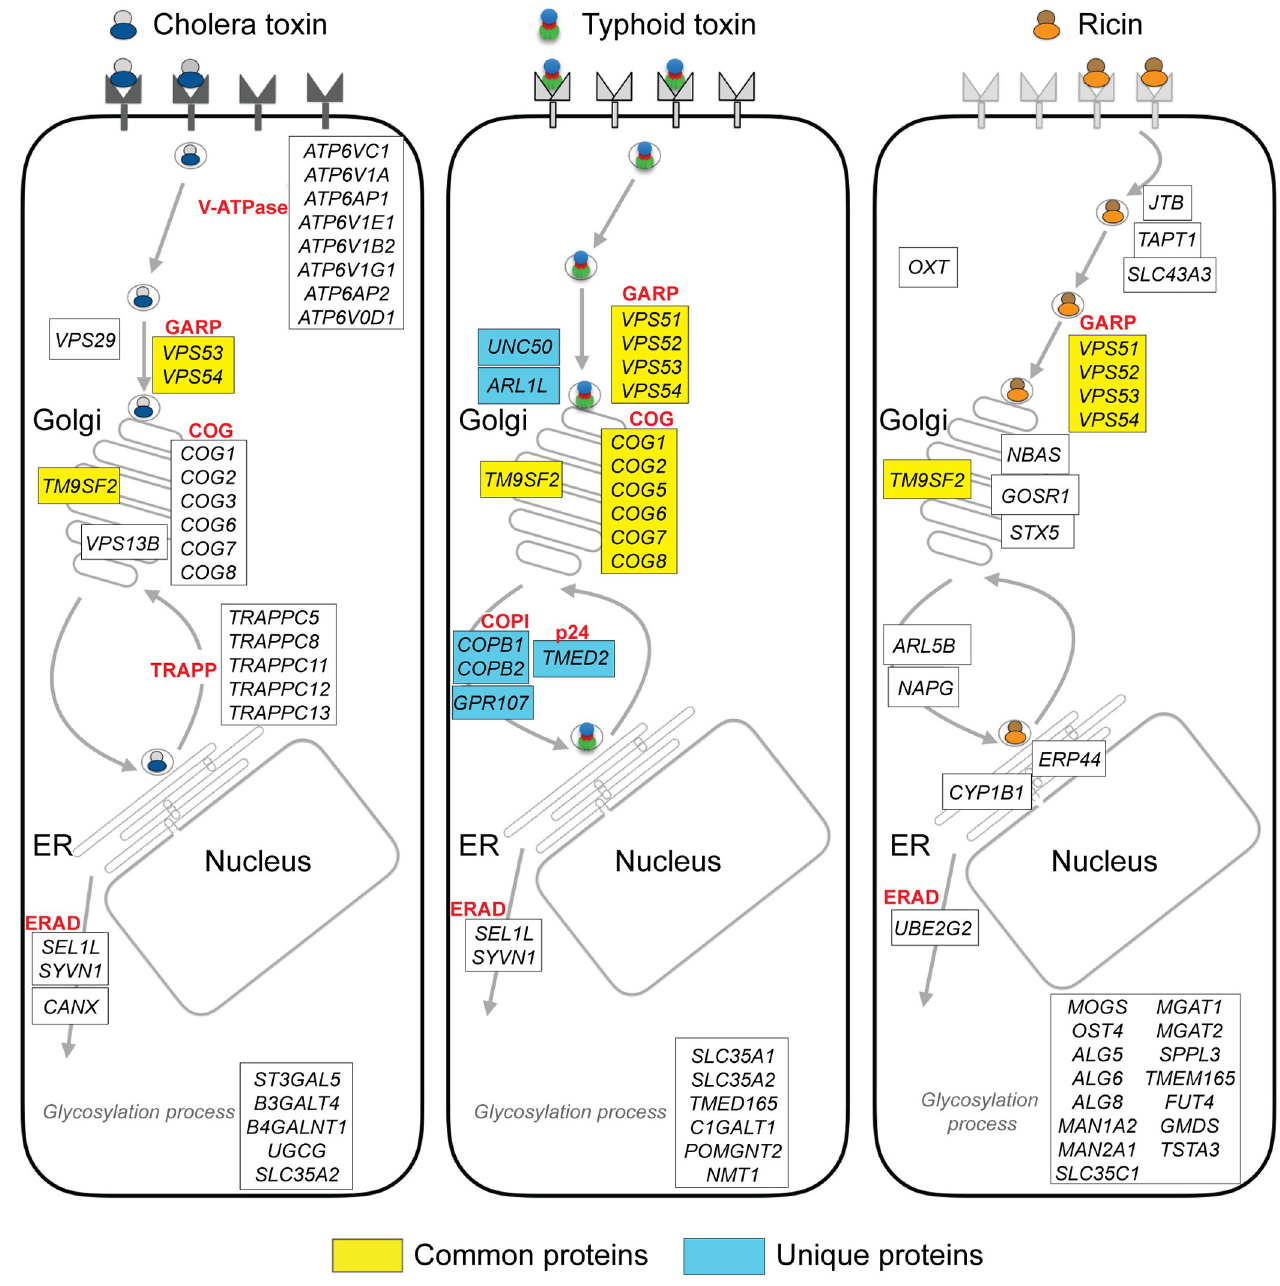
Fig 6. Common and distinct toxin transport pathways revealed by genome wide screens. Boxes indicate known physical complexes. Proteins involved in the transport of all the indicated toxins are depicted in yellow while proteins uniquely involved in typhoid toxin transport are indicated in blue. The trafficking models of cholera toxin and ricin are summarized from Gilbert’s et al. [50] and Tian et al. [51],